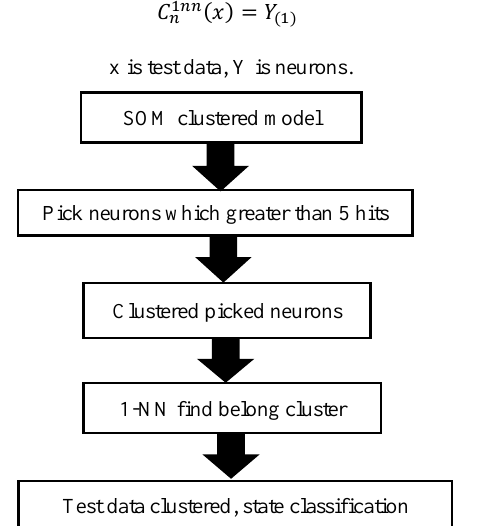
Figure 6. Process of